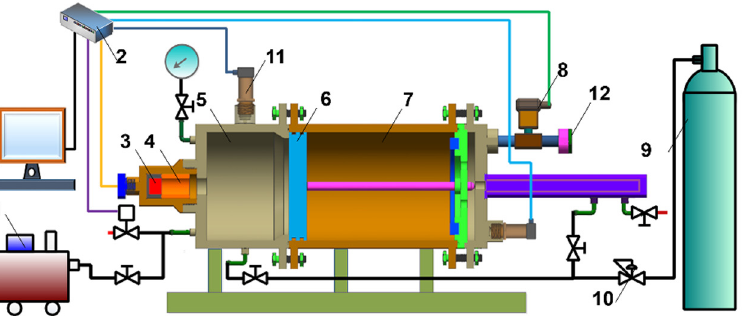
Figure 2. Schematic diagram of CCPs collection system. 1. vacuum pump 2. signal collector 3. pro- pellant grain 4. combustion chamber 5. collection chamber 6. piston 7. regulation chamber 8. sole-